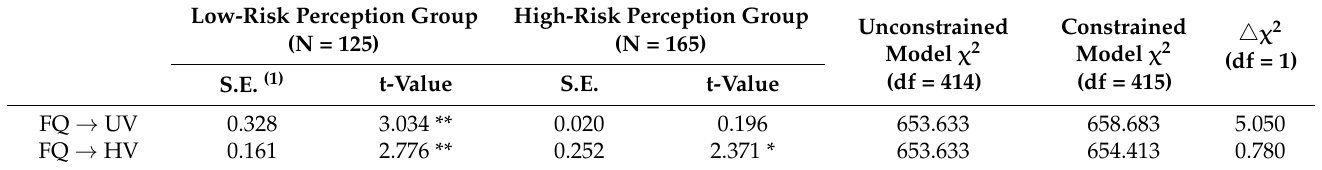
Table 6. Moderating effects of food safety risk